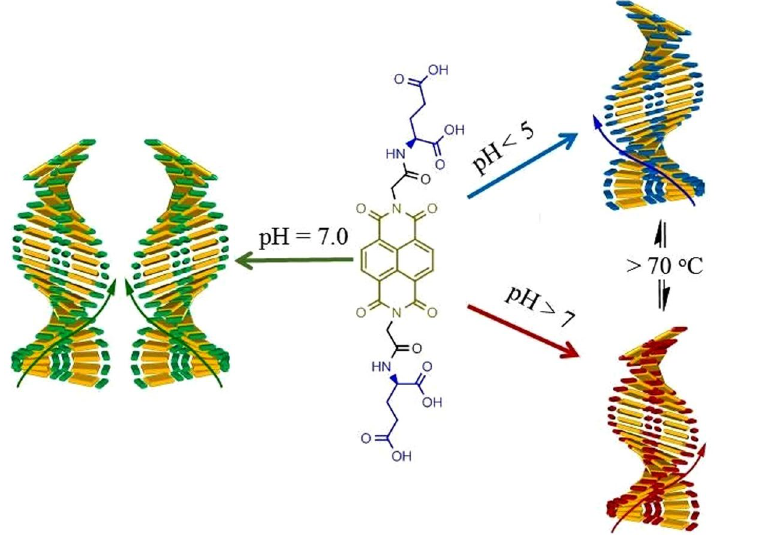
Figure 9. Graphical illustration of the handedness of a man-made supramolecular object can be controllably tuned with the action of pH and